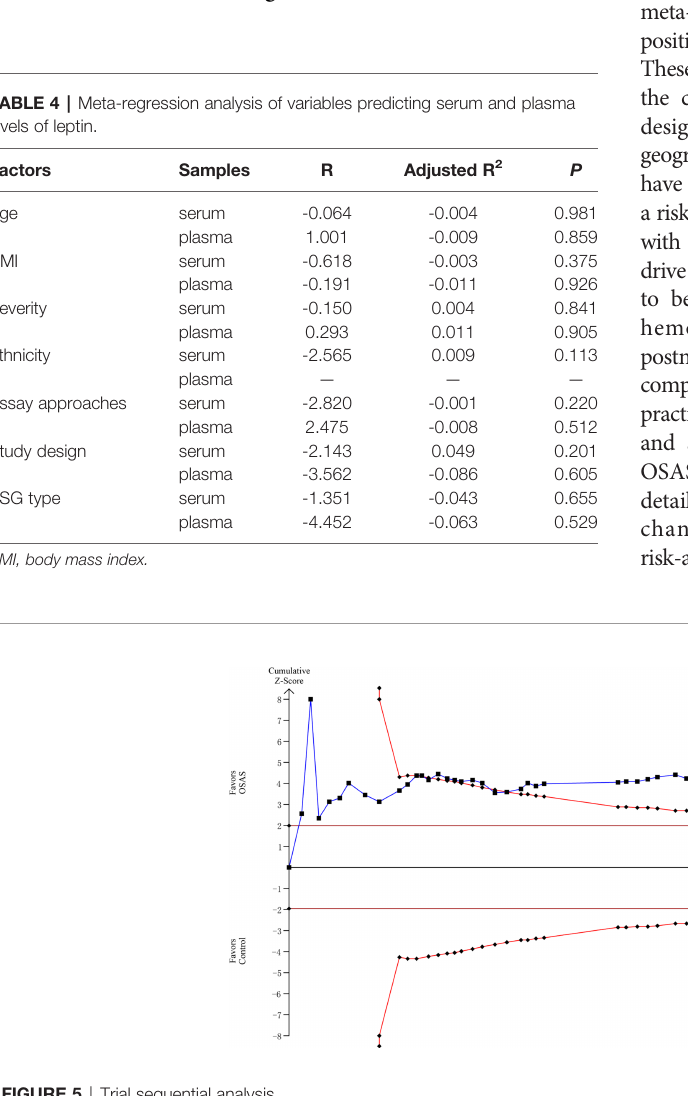
FIGURE 5 | Trial sequential